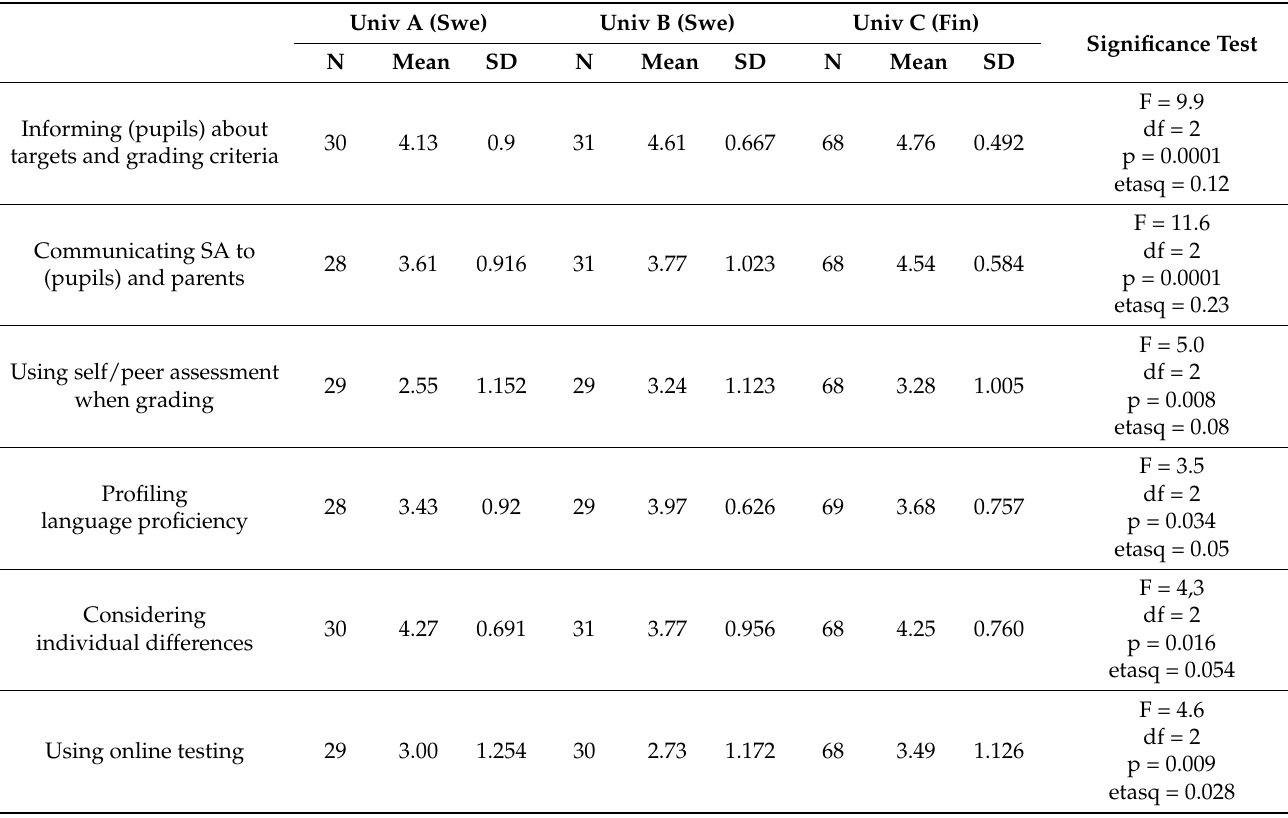
Table 4. Pre-service teachers’ perceived importance of summative assessment practices by university.